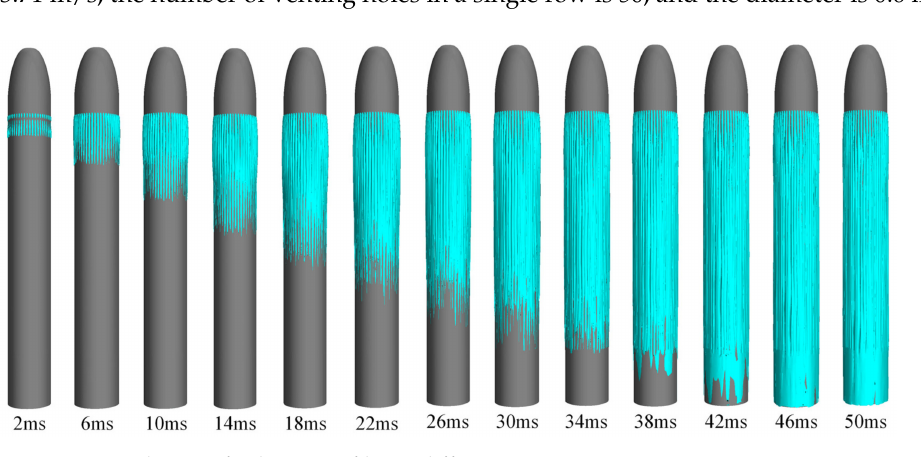
Figure 10. Evolution of exhaust air film at different times.